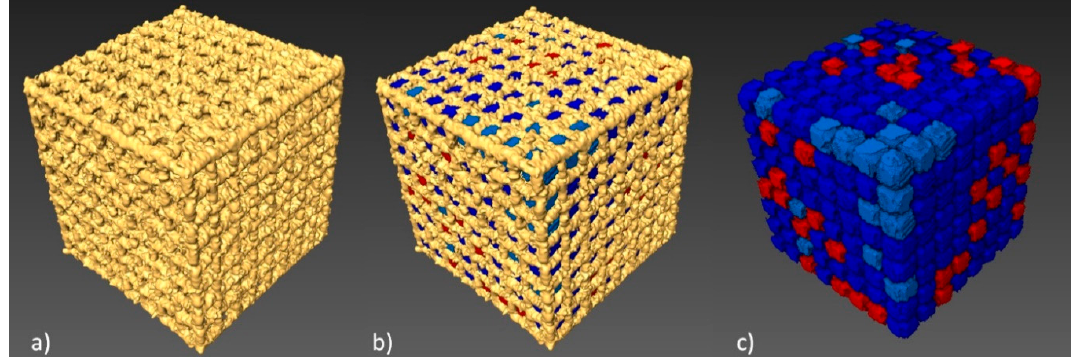
Figure 7. Porosity analysis of BFS structure: ( a ) CT image thresholding for BFS structure geometry, ( b ) BFS structure with porosity values, ( c ) pores after the separation process with colors indicating their differing volumes.